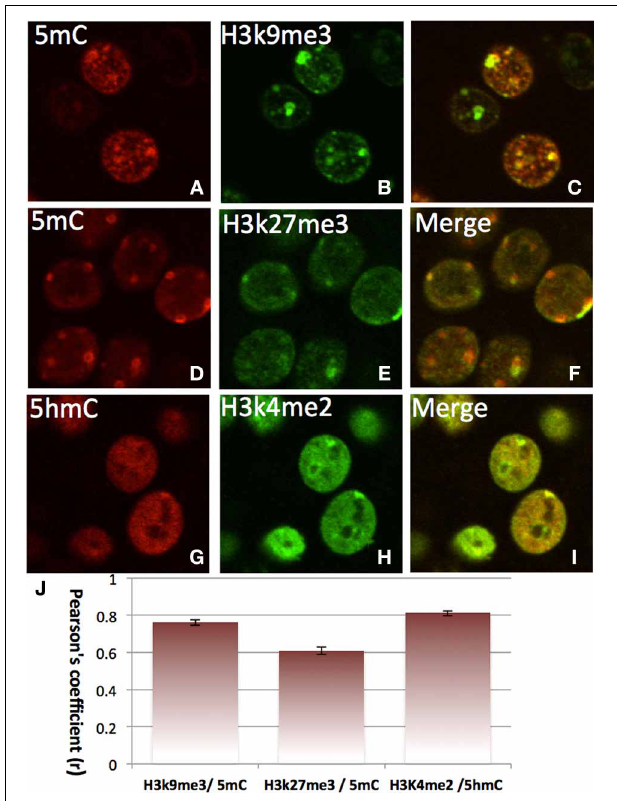
FIGURE 7 | Differential colocalization of 5mC and 5hmC with histone marks in nuclei of differentiated neurons in P7 cortex indicated by two color-fluorescence confocal microscopy. The 5mC ( A,D , red) is closely colocalized with suppressive histone marks H3K9me3 ( B , green) (merged in C ), and H3K27me3 (E , green ) ( merged in F) . In contrast, the 5hmC (G , red ) is highly co-localized with the activating histone mark, H3K4Me2 (H , green ) as demonstrated in the merged image (I) . Pearson’s coefficient is shown in chart J . Data presented as Mean ±